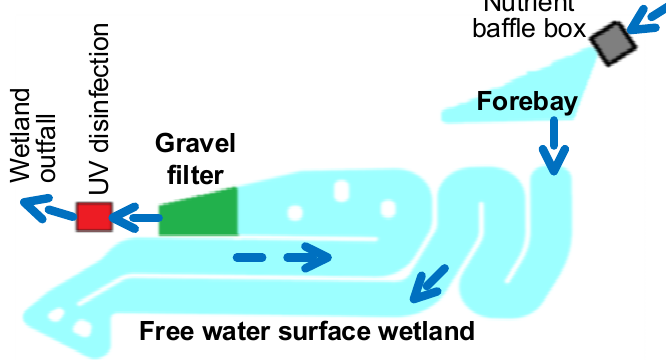
Figure 4. Layout of Washington CSO wetland treatment system. Source: Drawing with reference to Google Map at maps.google.com on 12 August 2014 and description by Harrison and Kasthuri [19].